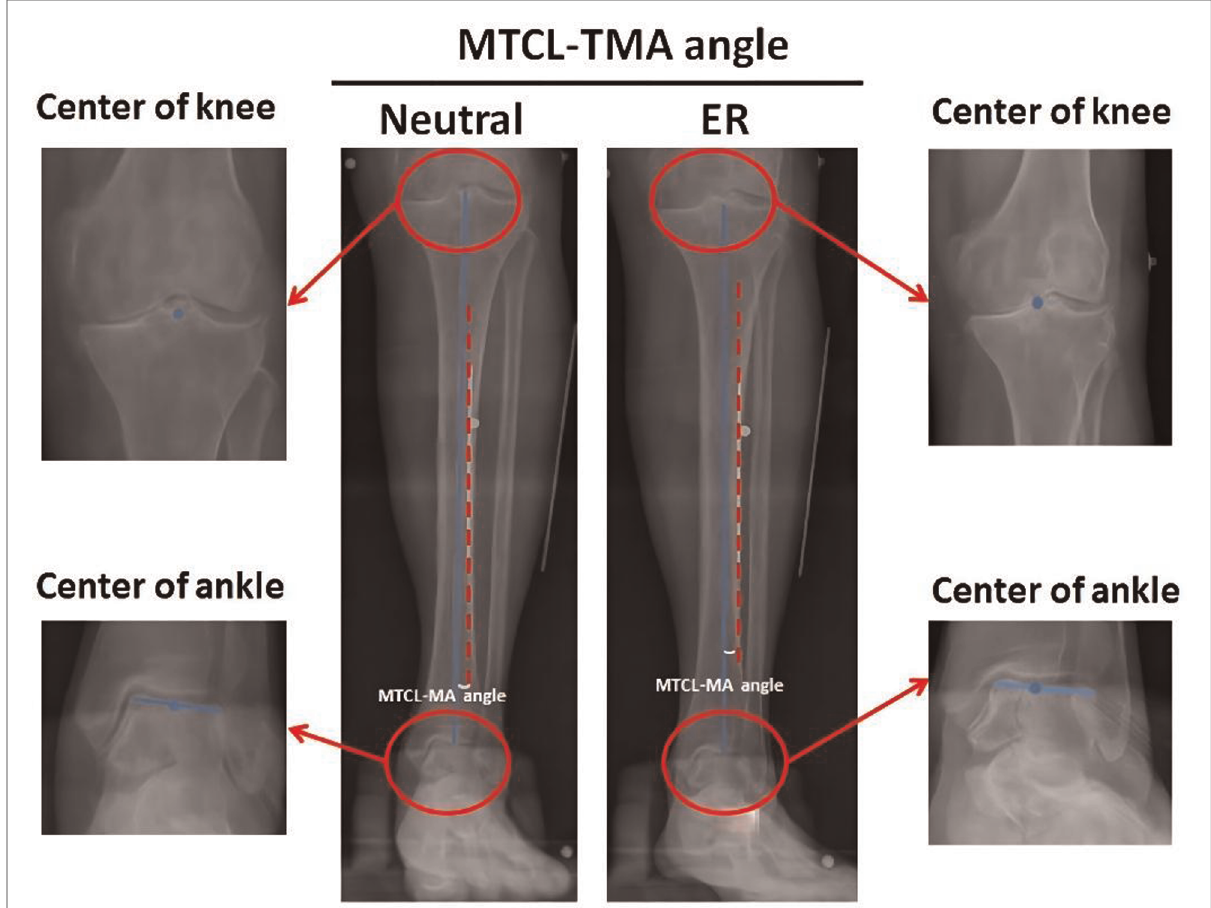
FIGURE 2 Measurement of the MTCL – TMA angles. The tibial mechanical axis (TMA) (blue line) is de fi ned by connecting the points between the centers (blue dots) of the knee and ankle. The MTCL is de fi ned as the red dotted line. The MTCL – TMA angle was automatically calculated by PACS